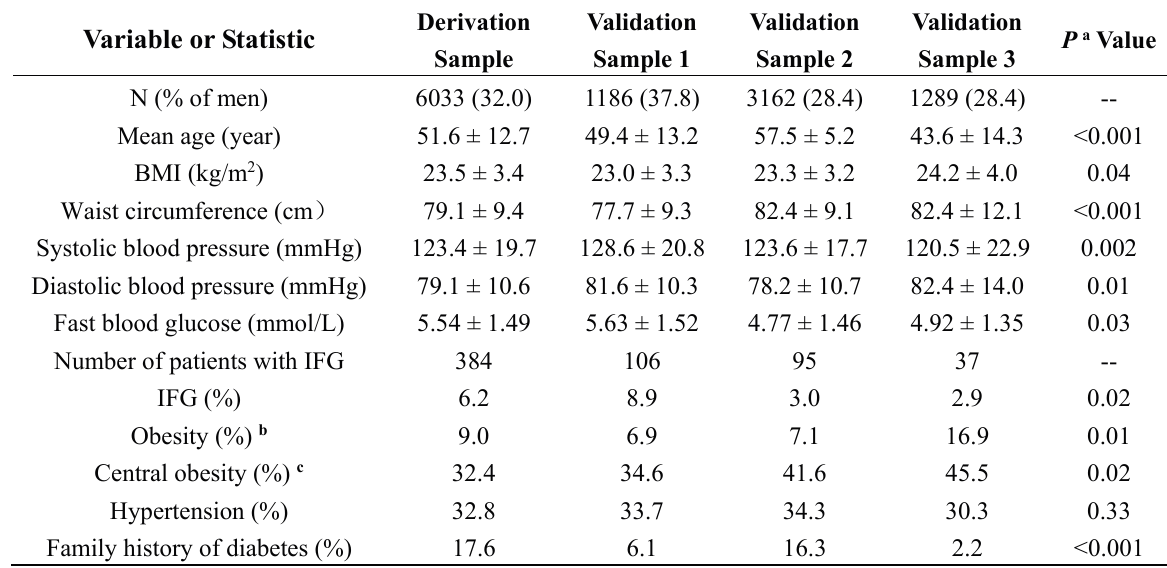
Table 1. Baseline characteristics of the four different study